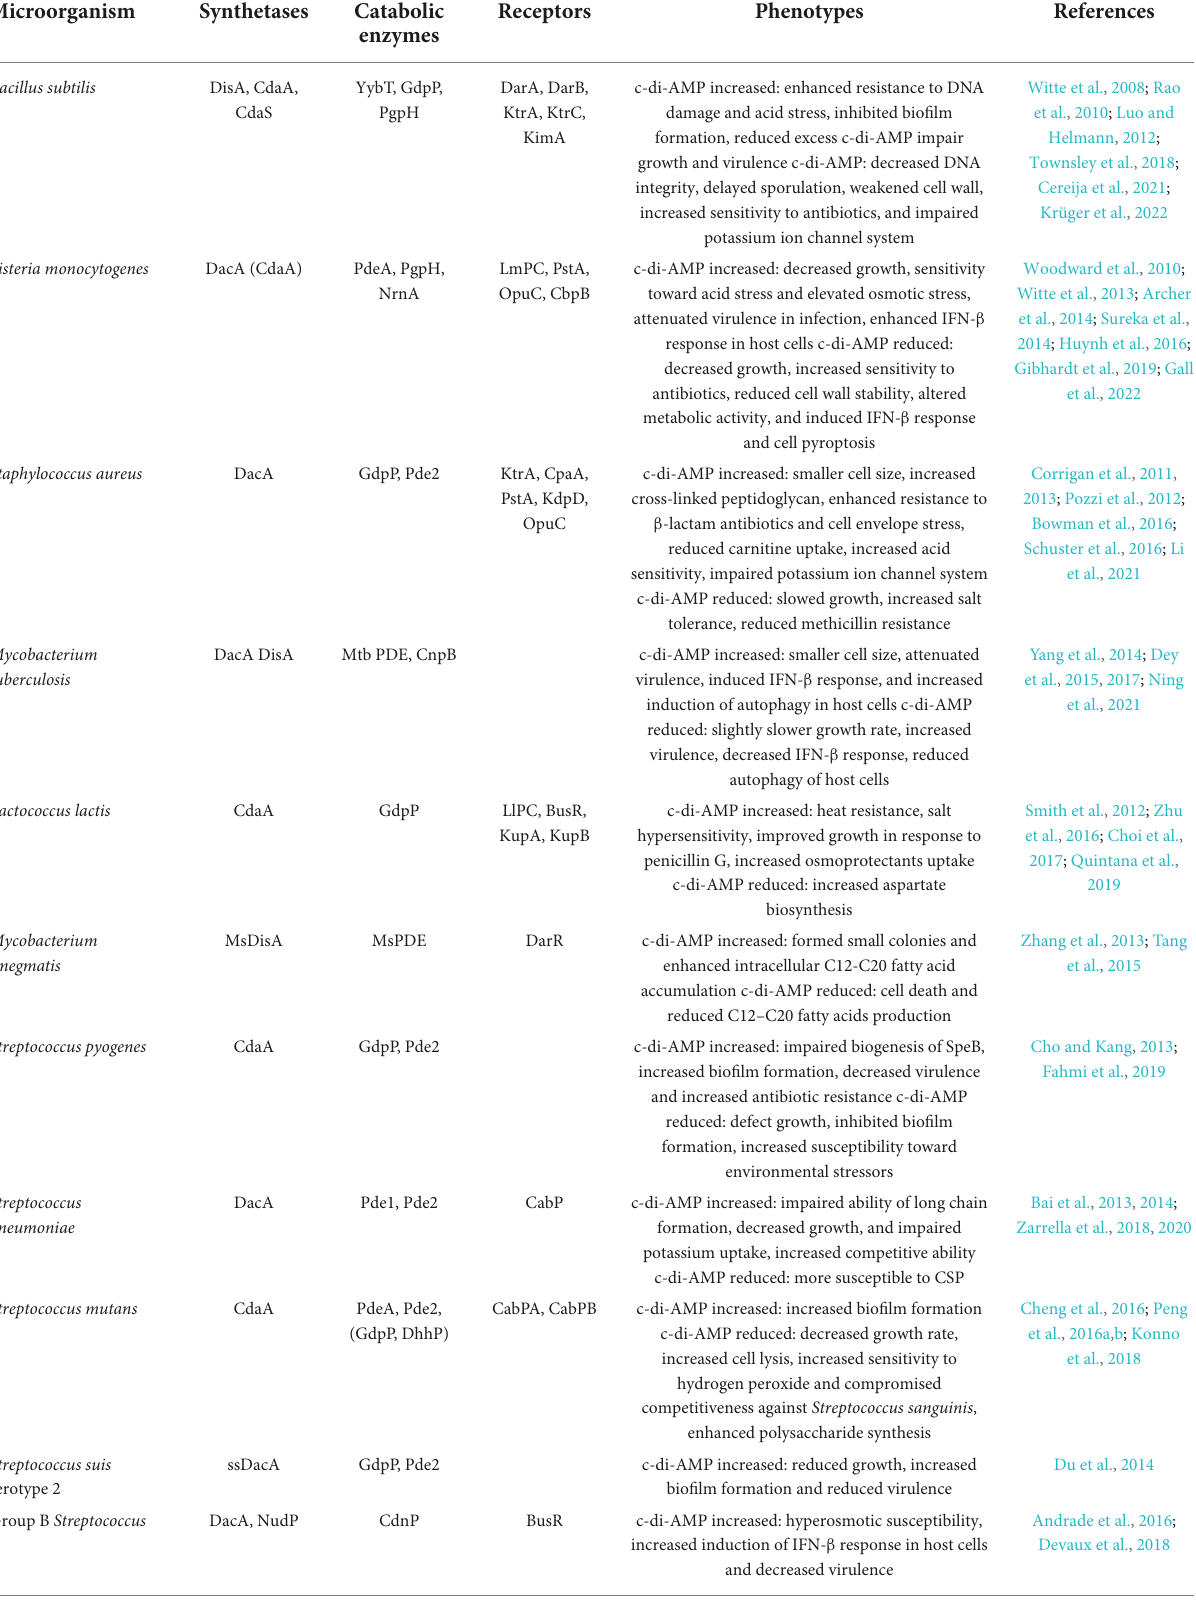
TABLE 1 Summary of cyclic di-adenosine monophosphate (c-di-AMP) synthetases, catabolic enzymes, and related physiological functions in bacteria and archaea.